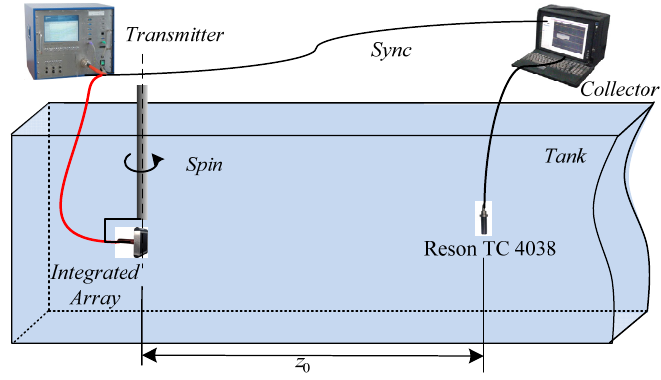
Figure 9. Schematic diagram of integrated array sound source test.